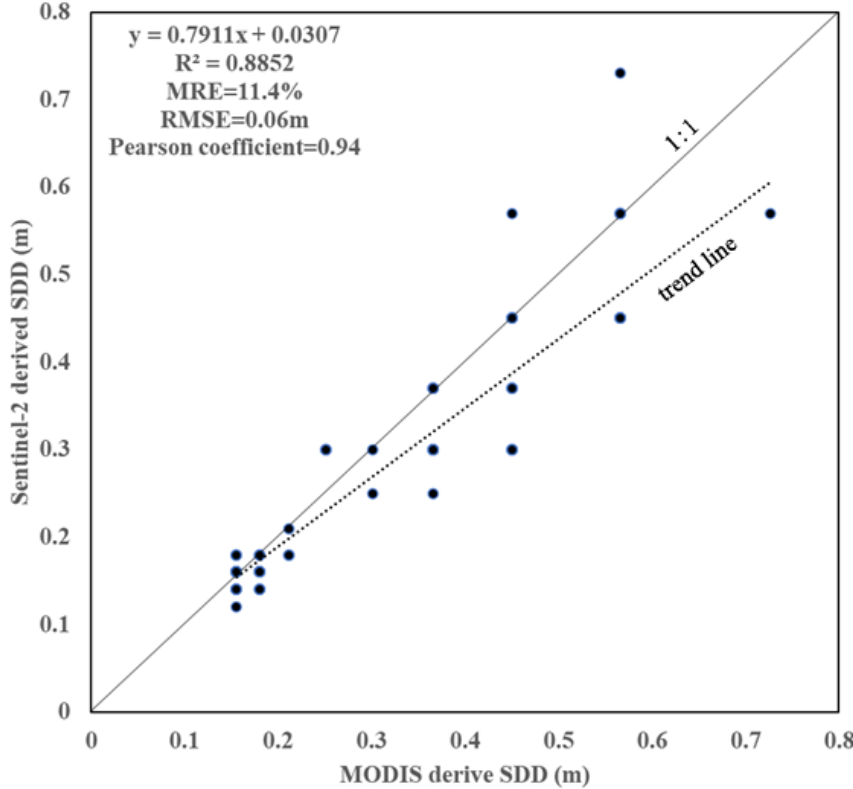
Figure 5. Scatterplots showing the derivation of accuracies of MODIS derived SDD in comparison with Sentinel-2 derived